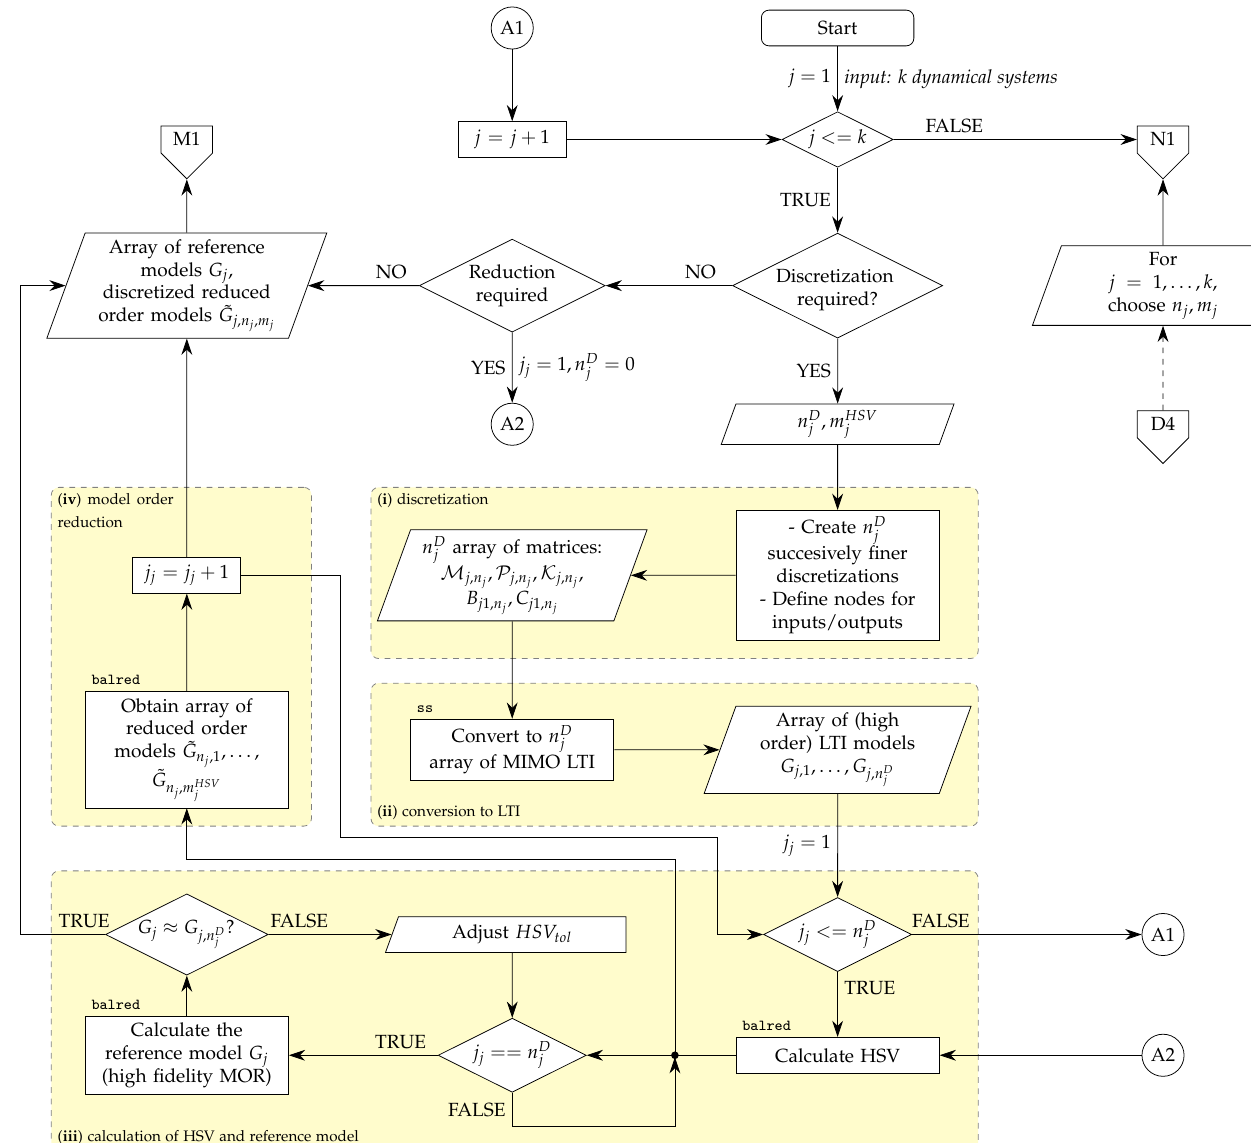
Figure 3. A preprocessing step for obtaining and storing of arrays of LTI models: reference models ( G j ) and discretized reduced order models ( ˜ G j , n ). For each discretized system, n j = 1, . . . , n D j j , m j discretized LTI models are made. For discretized models, a reference model is created by choosing the best available discretization (i.e., n j = n D ) that is reduced using high fidelity balanced truncation j method—a step analogous to obtaining a minimal realization. For each reduced order model,